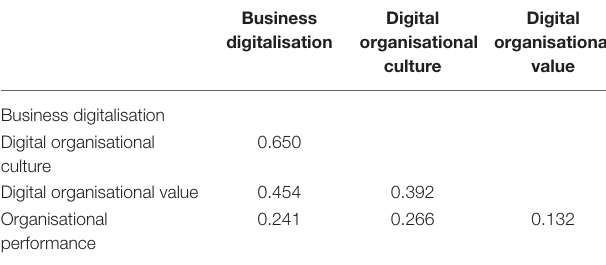
TABLE 4 | Heterotrait–Monotrait ratio of